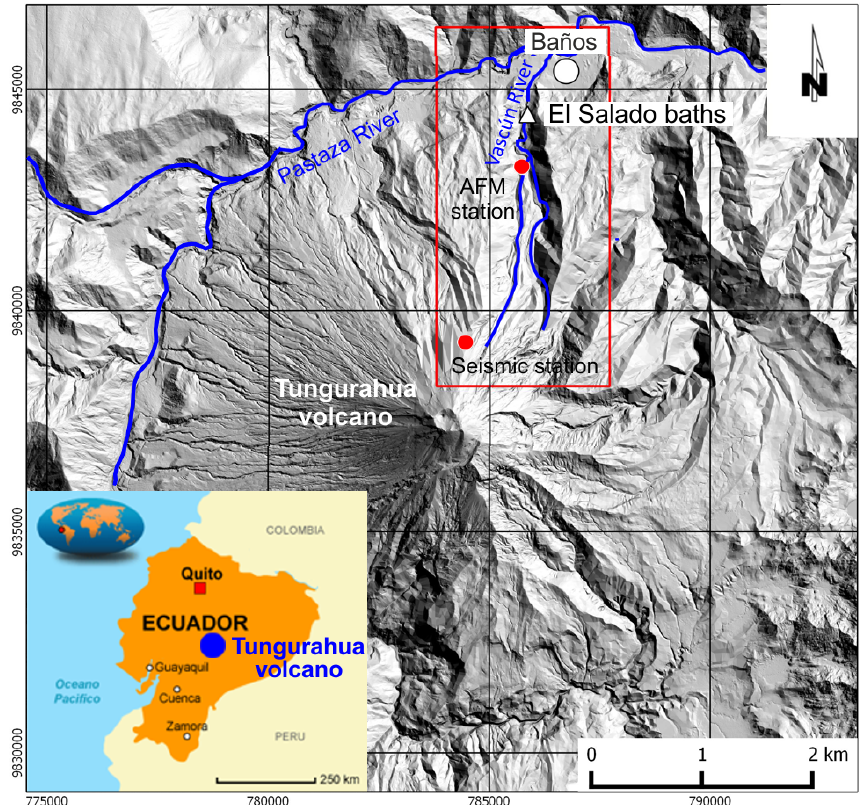
Figure 1. Tungurahua volcano. The Vascún valley is inside the red